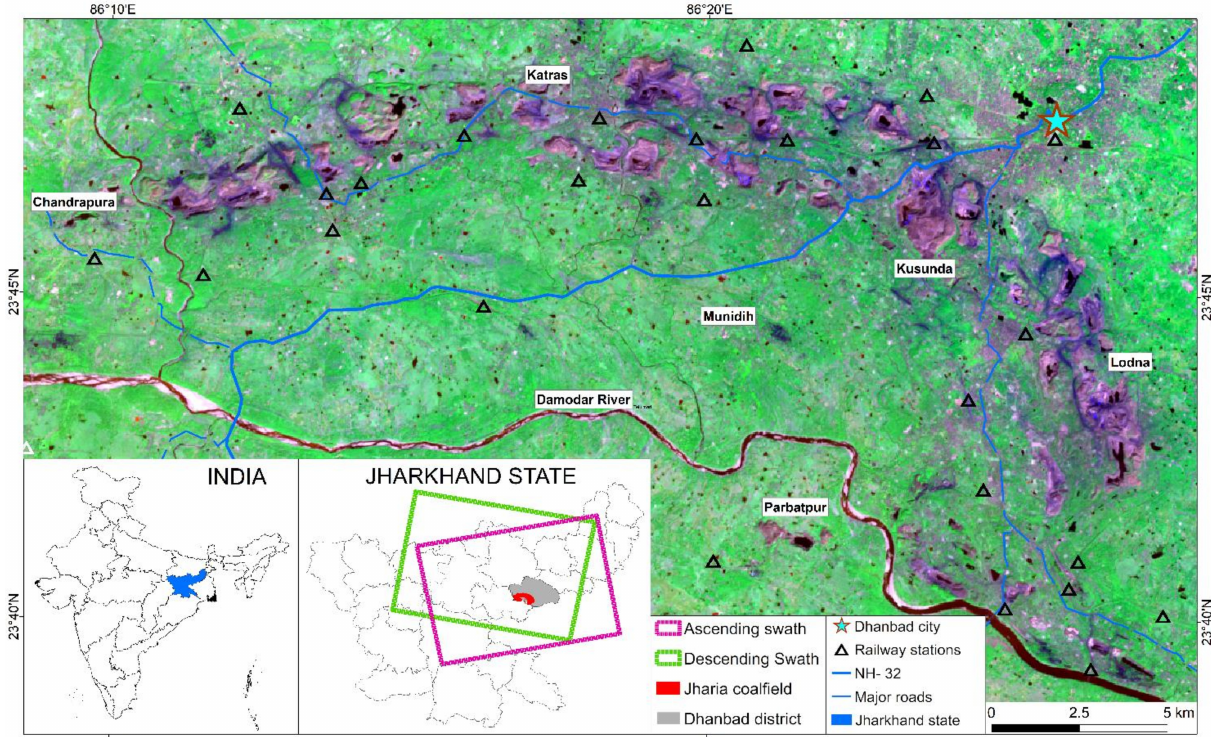
Figure 1. Study area map showing a false-color composite of Jharia coalfield (JCF). Features having violet color in the map are opencast mines. Sub-plots showing the country map and the state map are also included in the figure. The swath of Sentinel-1 SAR data for ascending and descending paths are also shown in the map subset that portrays the state map of